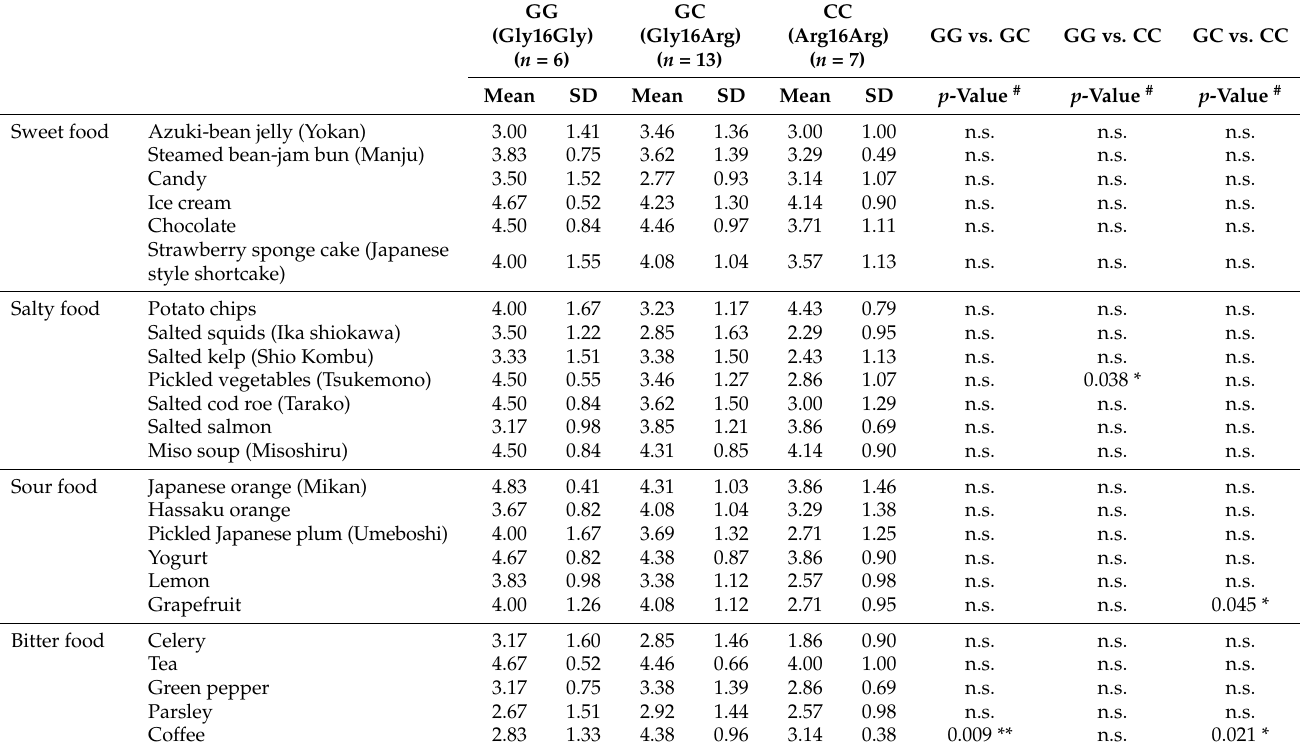
Table 5. Food preference in female subjects with the GG (Gly16Gly), GC (Gly16Arg), and CC (Arg16Arg) genotypes of ADRB2